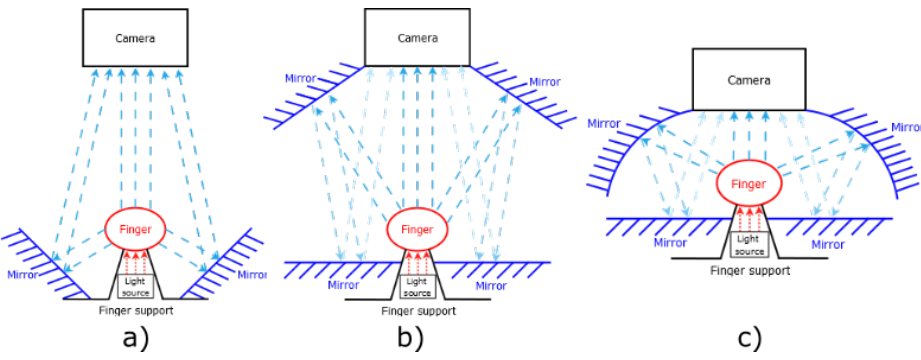
Figure 10. Three possible setups of the scanner ( a ) reflecting area as close as possible to finger; ( b ) reflection from the top of the finger; ( c ) curved reflection